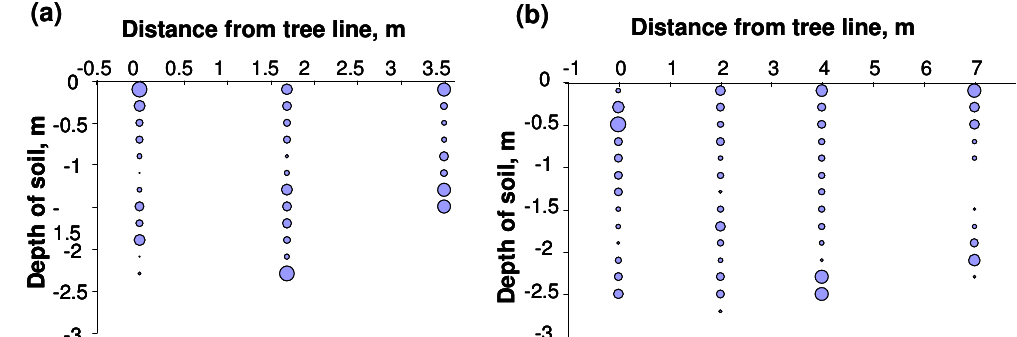
Fig. 4. Fine root density (note the size of the blue bubbles) at different depth and distance from tree in FRS (a) and AFS (b) trees